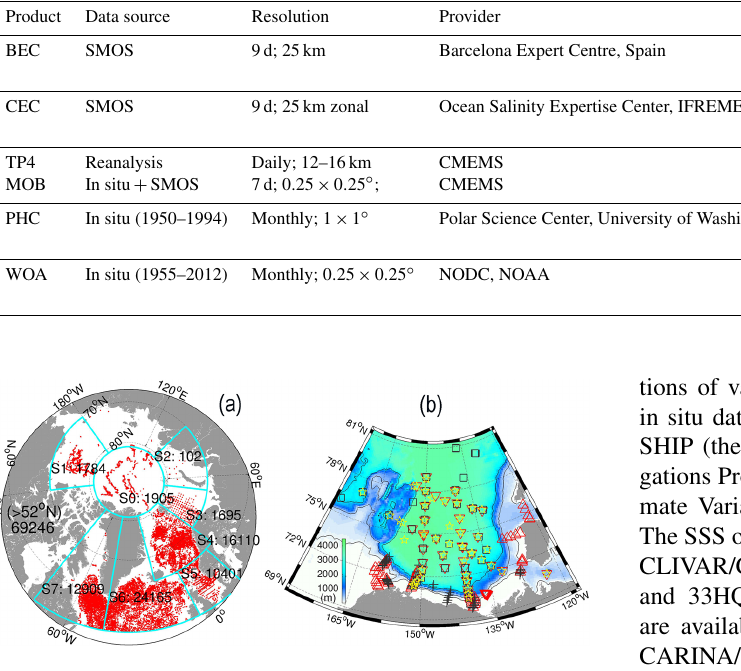
Figure 1. (a) SSS locations of the in situ observations north of 52 ◦ N in CORA5.1 during the years 2011–2013. Eight sub-regions divide the Arctic Ocean (S0–S4) and the northern North Atlantic Ocean (S5–S7), with the number of observations indicated in each region. (b) Independent SSS observations in the Beaufort Sea dur- ing the summer months of 2011–2013 from the BGEP (marked by inverted triangles, squares, and stars) and the CLIVAR (marked by triangles and crosses). Different colors (red, black, and yellow) in- dicate the years (2011, 2012, and 2013,